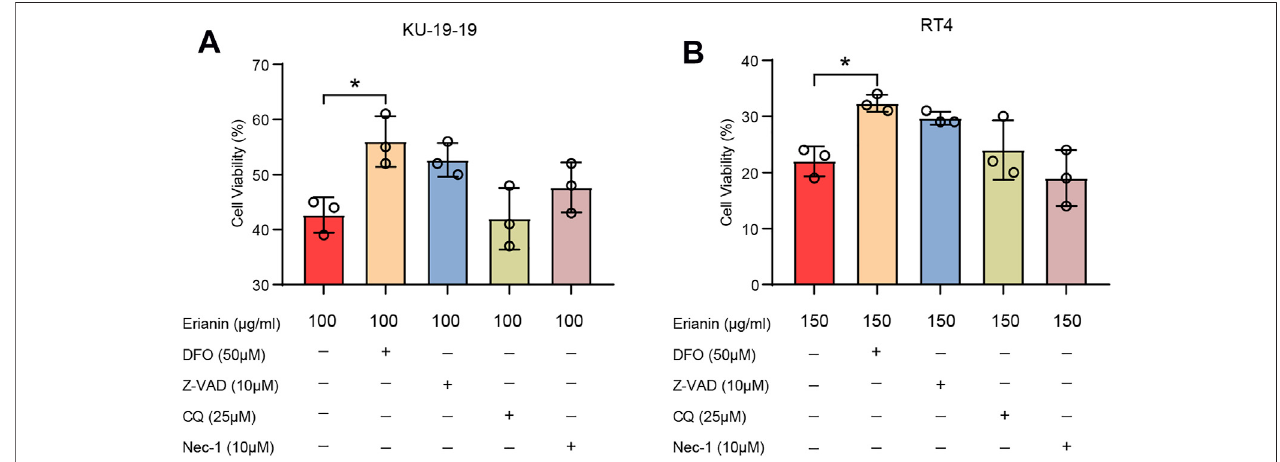
FIGURE 2 | KU-19 – 19 and RT4 were treated with erianin in combination with or without other cell death inhibitors Nec-1, DFO, Z-VAD and CQ for 24 h, then cell viability was assayed. * p < 0.05.